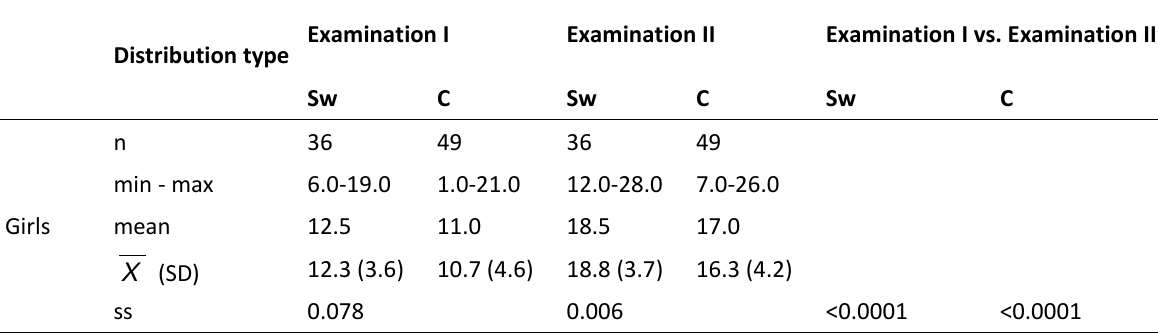
Table 7. Descriptive characteristics of Sit-Up Test (torso strength) results in the Swimmers (Sw) and Control (C) groups